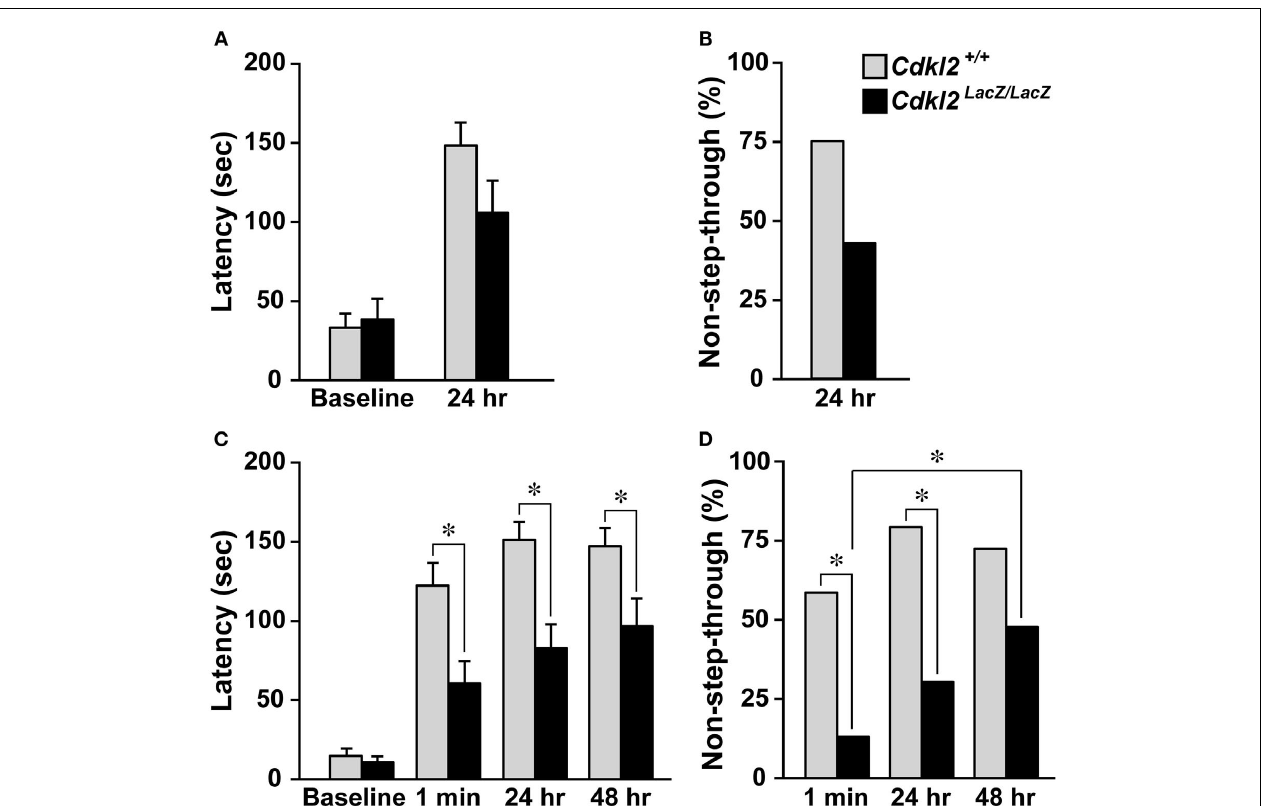
FIGURE 4 | Inhibitory avoidance test. When the animals had stepped with all four paws into the dark compartment, the door was closed and the baseline latency was recorded. The animals were given a single footshock (0.4 mA for 5 s) and then placed in their home cages. Retention was tested by placing the mice in the lighted compartment and measuring the latency to enter the dark compartment. (A) Step-through latencies to enter the dark compartment were measured 24 h after footshock. Statistical analysis was performed using the Mann-Whitney U -test. The baseline latencies were not signifi cantly different between genotypes ( U = 102.5, P = 0.6926). In the 24-h retention trials, Cdkl2 LacZ/LacZ mice exhibited reduced latencies, but the difference was not signifi cant ( U = 74.0, P = 0.0745). (B) The percentage of mice that did not enter the dark compartment (non-step-through) in 24-h retention trials was